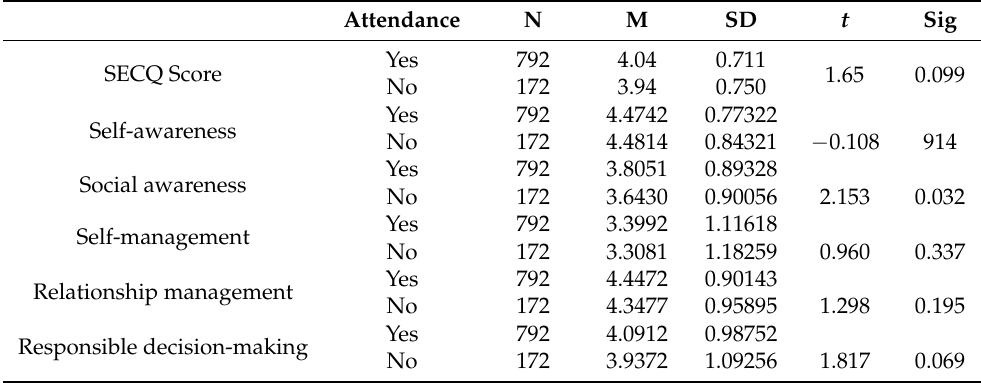
Table 4. Student’s t test results for the variable attendance at extracurricular activities.